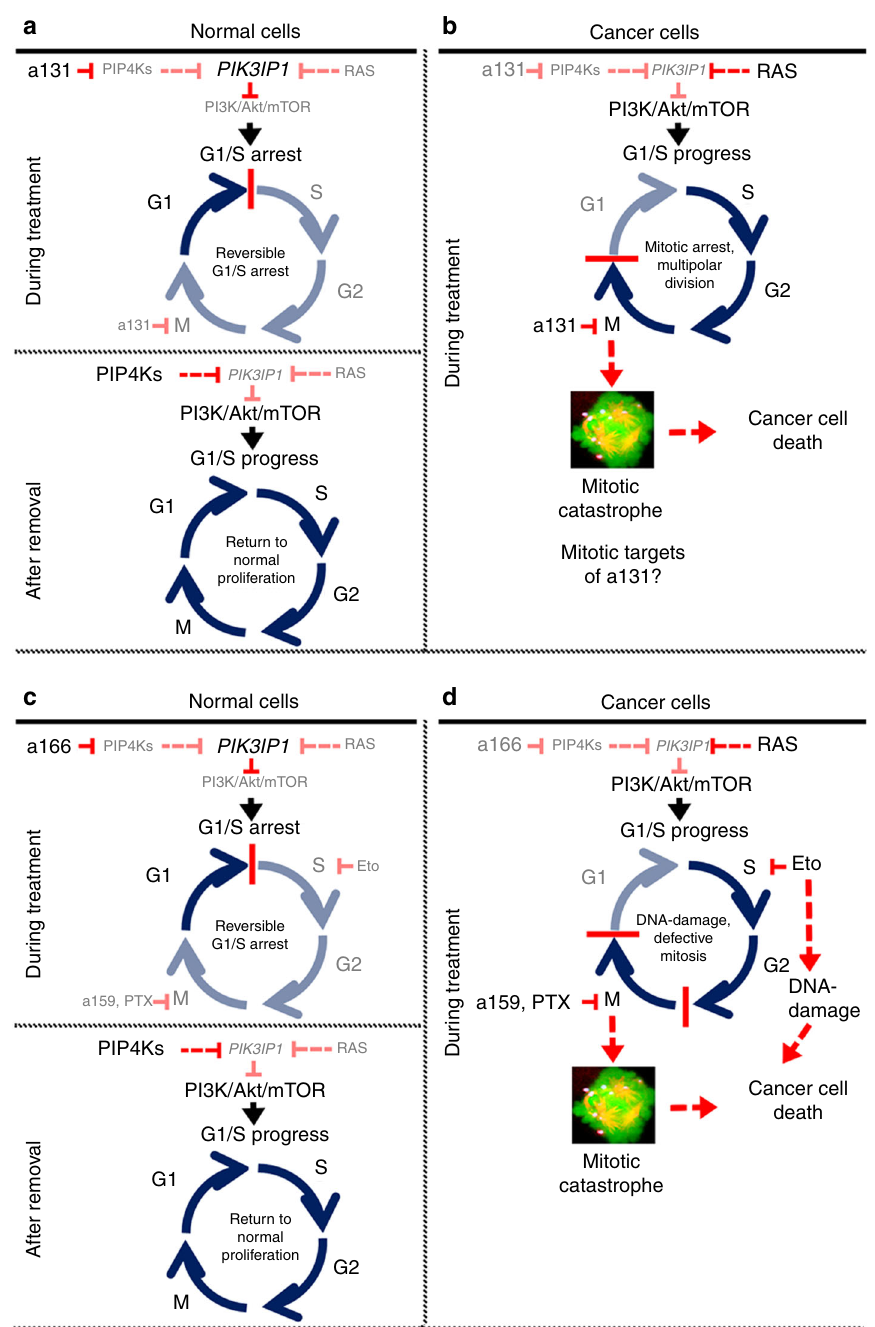
Fig. 6 Proposed model. Inhibition of PIP4Ks by a131 or a166 arrests normal cells at the G1/S phase of the cell cycle by suppressing the PI3K/Akt/mTOR signaling pathway via transcriptional upregulation of PIK3IP1 ( a , top). This cell cycle arrest is reversible after drug removal ( a , bottom). In contrast, mutation or activation of the Ras/Raf/MEK/ERK pathway in cancer cells promotes positive cross-talk with the PI3K/Akt/mTOR pathway by negative transcriptional regulation of PIK3IP1 , which allows cancer cells to bypass a131-induced growth arrest at the G1/S phase of the cell cycle, but subsequently leads cancer cells to a131-induced mitotic catastrophe and cell death. However, it is important to note that the mitotic targets of a131 remain unidenti fi ed b . Pretreatment with a166 protects normal cells from chemotherapeutic toxicity by arresting normal cells at the G1/S phase of the cell cycle c . In contrast, mutation or activation of the Ras/Raf/MEK/ERK pathway in cancer cells bypasses the growth arrest, leading to cell death caused by chemotherapeutic drugs (Eto, etoposide; PTX, paclitaxel) and a159 d . Of note, this Ras ˧ PIK3IP1 ˧ PI3K signaling network identi fi ed in this study may contribute to “ oncogene collaboration ” of the